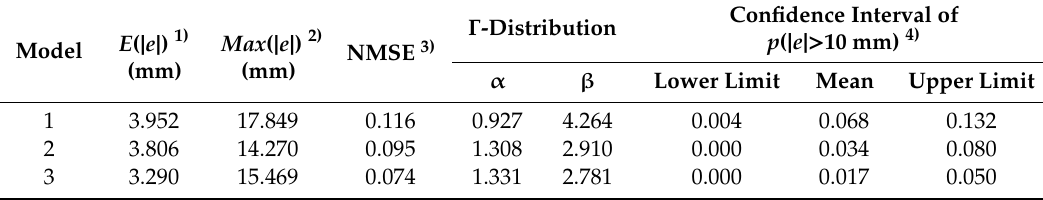
Table 8. Error distribution of